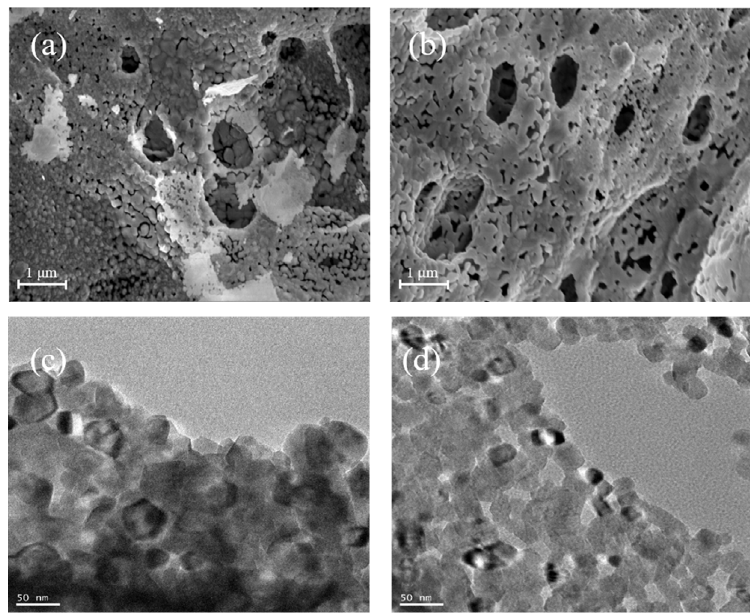
Fig. 2 FE-SEM images of the x = 0.01 NCs annealed at (a) 1000 ℃ and (b) 1200 ℃ and HR-TEM images of the x = 0.01 NCs annealed at (c) 1000 ℃ and (d) 1200 ℃ .